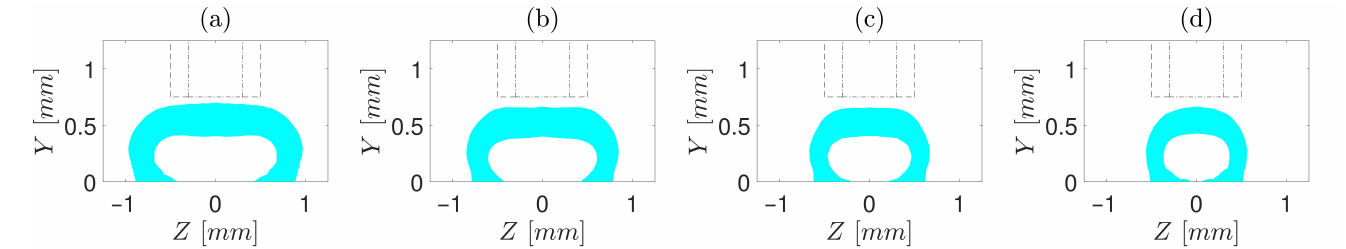
Figure 8. Cross-sections of the core–shell strand for t / D = 0.75, d / D = 0.6 and different V / U of ( a ) 0.5, ( b ) 0.75, ( c ) 1, and ( d ) 1.25. Core diameter and orifice are marked by “- -” and “-·”,